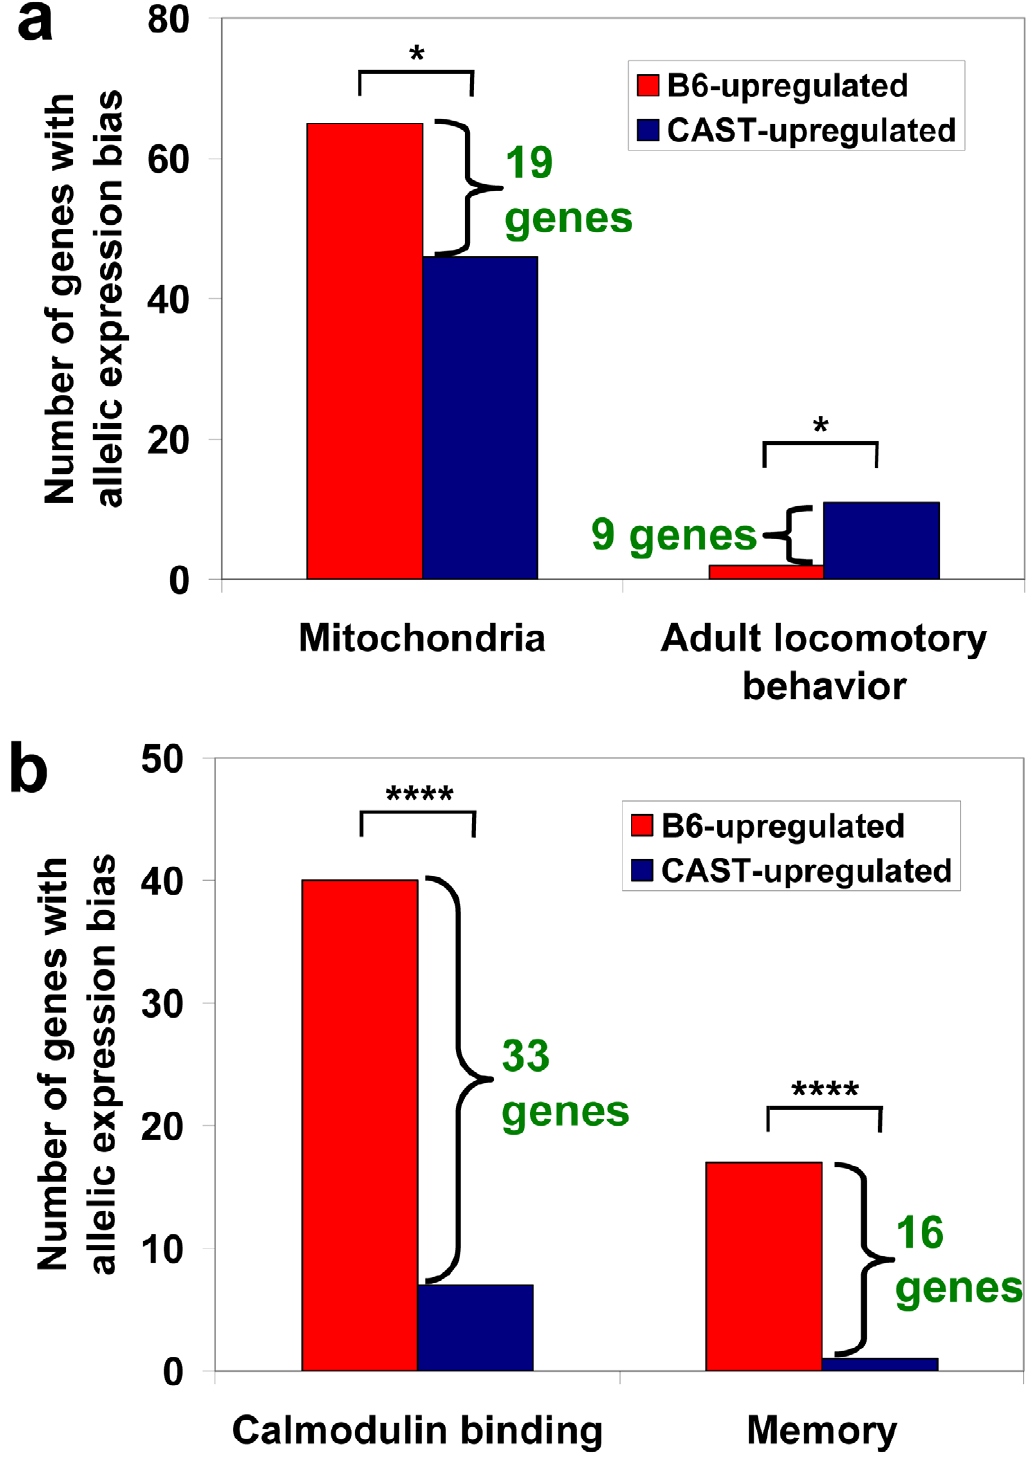
Figure 3. Results of the selection test in RNA-seq data. (a) Directions of allelic expression bias for mitochondria and locomotory-related genes in day 9.5 embryos. The significance indicated by asterisks is the same as in Figure 2. (b) Directions of allelic expression bias for calmodulin-binding and memory-related genes in day 9.5 embryos.